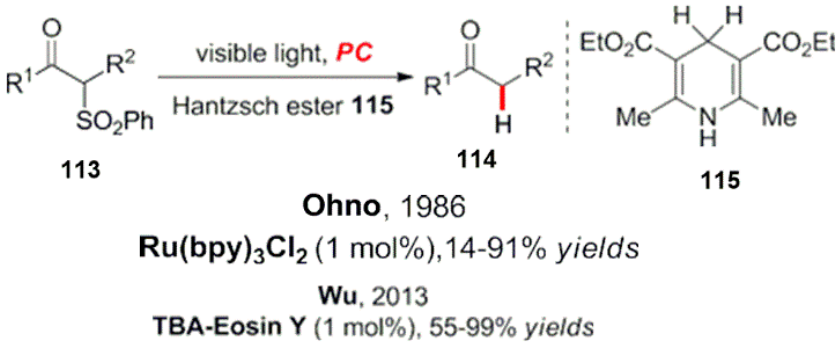
Scheme 37. Photocatalytic reduction desulfone